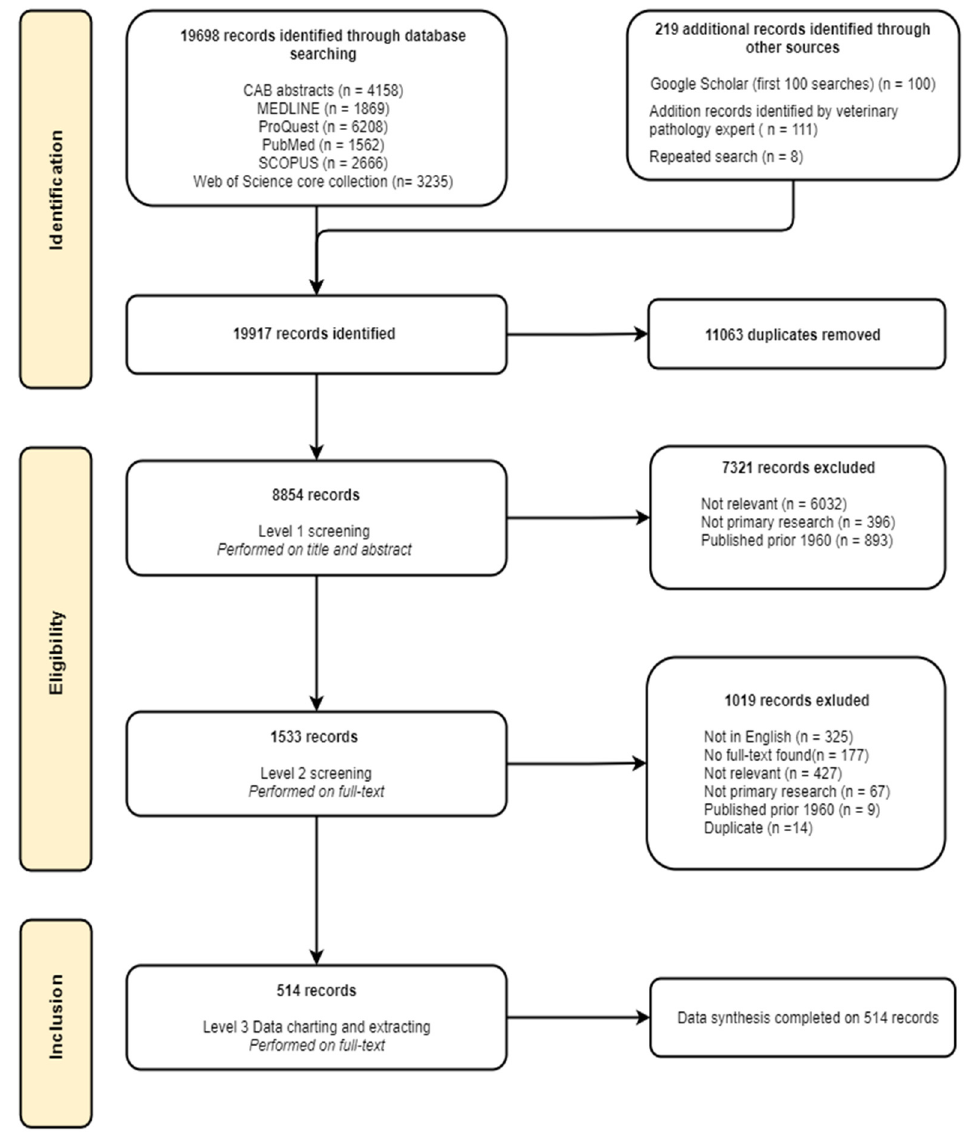
Figure 1. Flow chart of the numbers of studies identified, screened, assessed for eligibility, and included in a scoping review of causes and syndromes associated with mid to late-term pregnancy loss in horses.